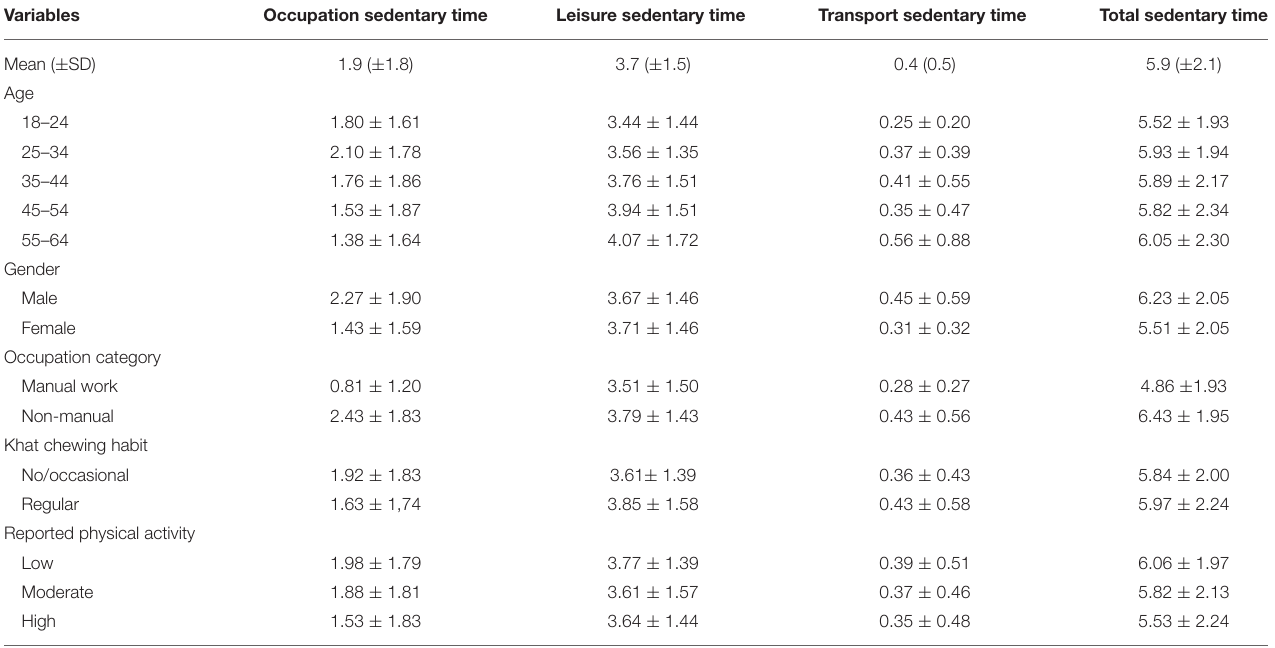
TABLE 3 | The mean ( ± SD) sedentary behavior by specific domain in hours per day among the study participant’s characteristics in Eastern Ethiopia, 2019. Variables